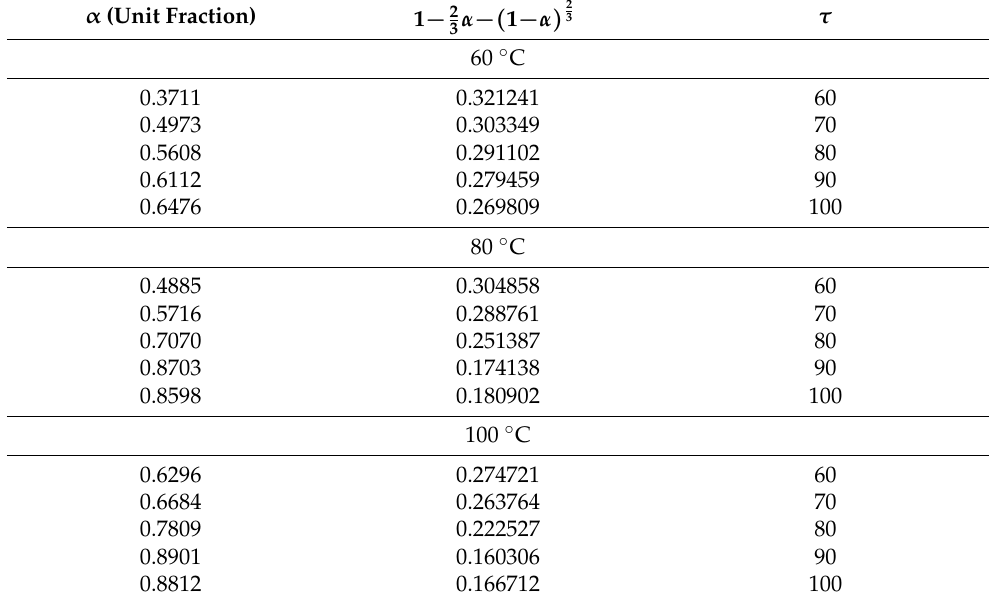
Table 5. Results of experimental data processing.